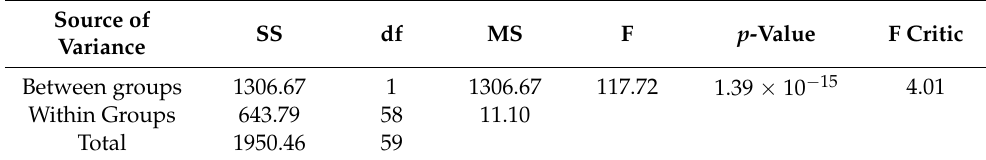
Table 22. ANOVA comparing results of Gaussian